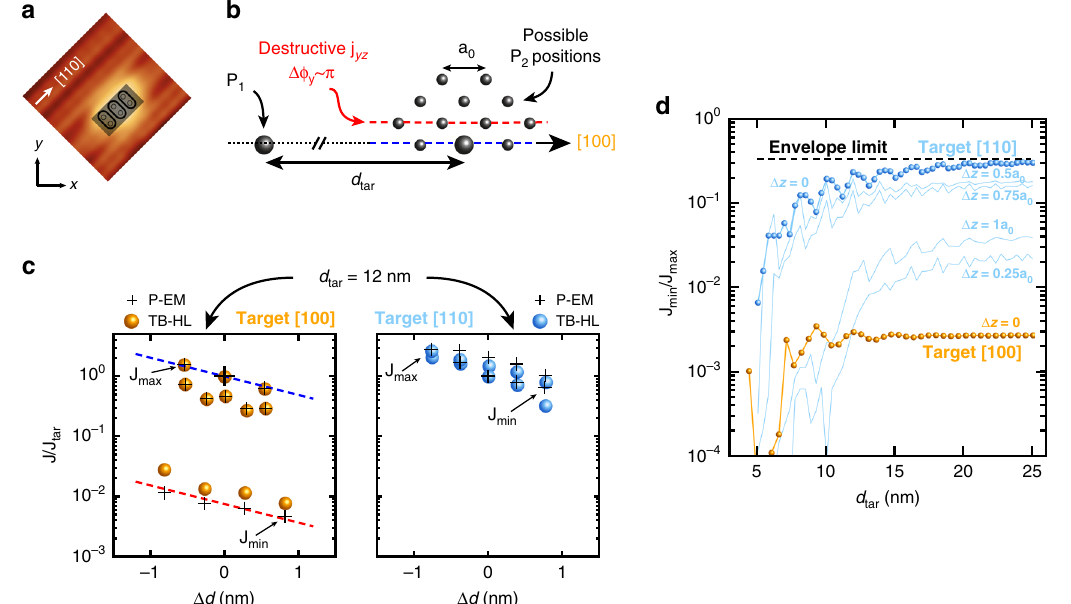
Fig. 7 Limited exchange in-plane variations for STM placed donors. a Single donors can be incorporated in a patch of three desorbed hydrogen dimers on the silicon surface, giving six possible positions for each donor. b There are 12 non-equivalent position con fi gurations for P 2 for a target along [100], taking the convention to fi x P 1 at the origin. A target along [110] results in ten possible con fi gurations. c Left: plot of the 12 possible exchange values along [100], normalised over the target one, plotted vs the distance difference Δ d = d − d tar with d tar = 12 nm, for both the P-EM (black crosses, the large one denotes the target) and TB-HL (orange balls) models. The con fi gurations along the red dashed line (same as b ) result in destructive j yz terms and their exchange values are reduced by more than two orders of magnitude compared to the con fi gurations perfectly aligned with [100] (blue dashed lines). Right: the exchange variations for a target along [110] are limited to less than a factor of 10 as j zz dominates, making the exchange interaction insensitive to in-plane valley interference. d Ratios J min / J max vs d tar between 5 and 25 nm for both [100] (orange) and [110] (blue). The impact of in-plane valley interference vanishes for target distances beyond 12 nm along [110], to bound exchange variations to the envelope limit. Destructive y -valley positions, and the degeneracy between j yz , j yy and j zz , are always present along [100] independently of the target distance, resulting in large exchange variations. The light blue lines show the exchange variations if the two donors are in different atomic z -planes, resulting in a fi nite z -valley phase